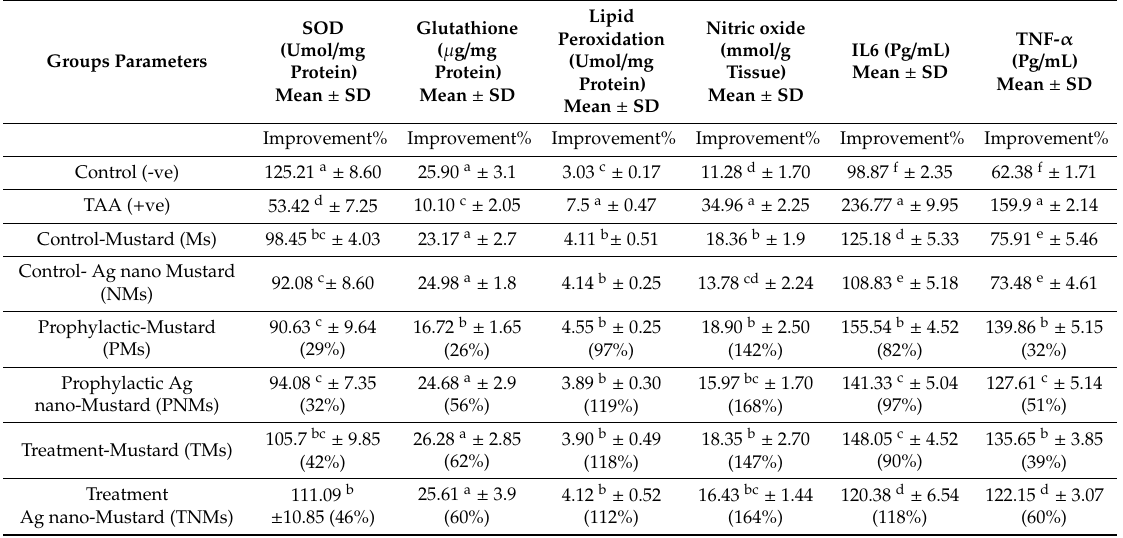
Table 4. Impacts of Brassica juncea L. (mustard) and its nanostructure on ROS and inflammatory cytokines.